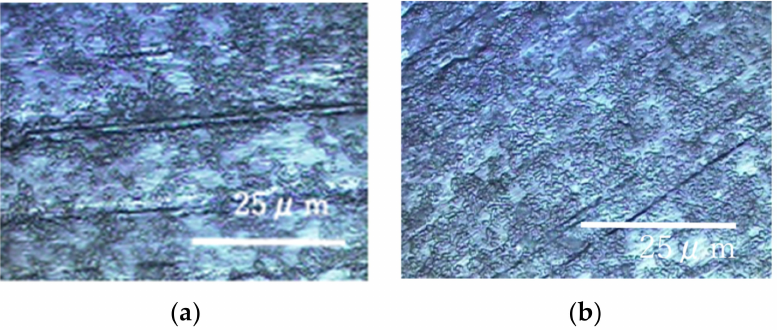
Figure 8. Specimens’ surfaces observed by the optical microscope in the RPDLBR: ( a ) titanium specimen and ( b ) aluminum specimen.